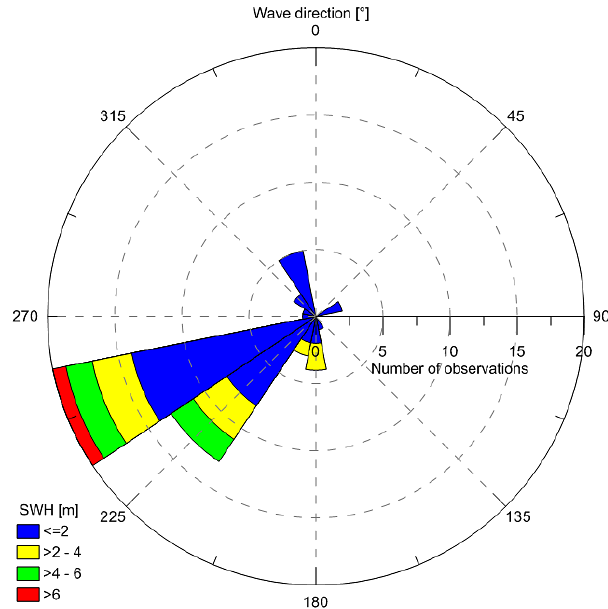
Figure 18. Wave rose at the point indicated on Fig. 16 for the period between 21hUTC 7 November 2007 and 6hUTC 14 November 2007.